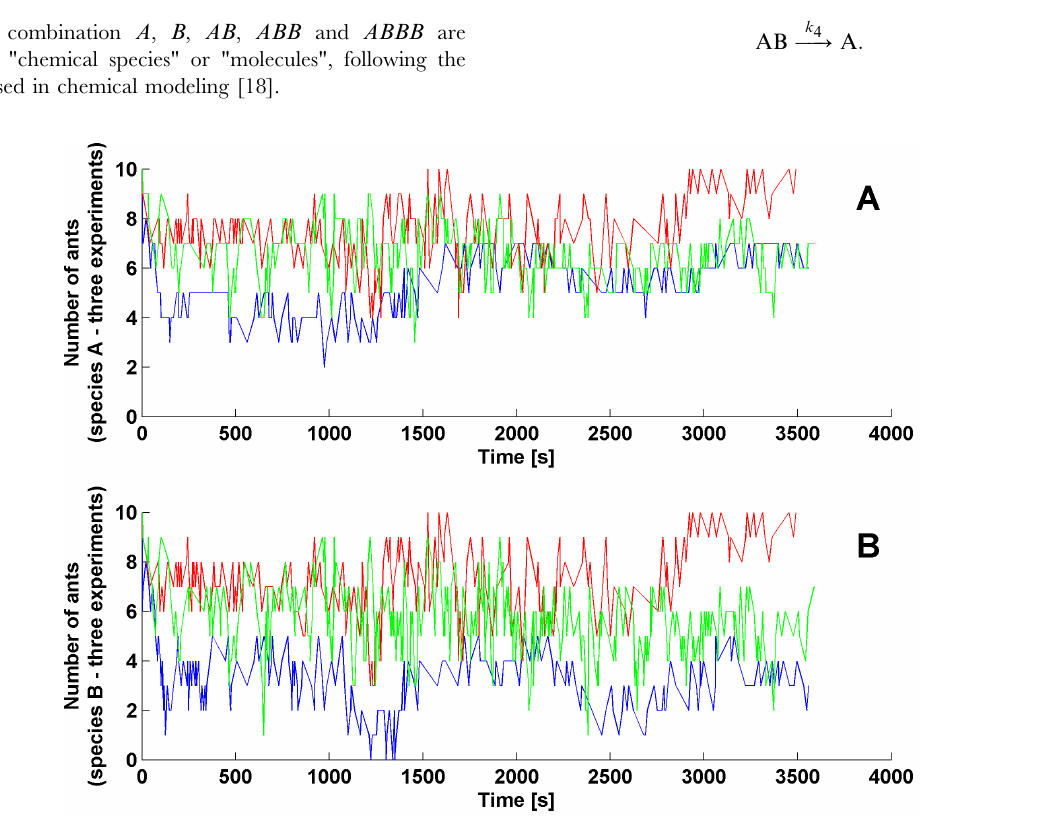
Figure 2. Experimental data. Abundance of A (subfigure (a)) and B (subfigure (b)) species from three different experiments.